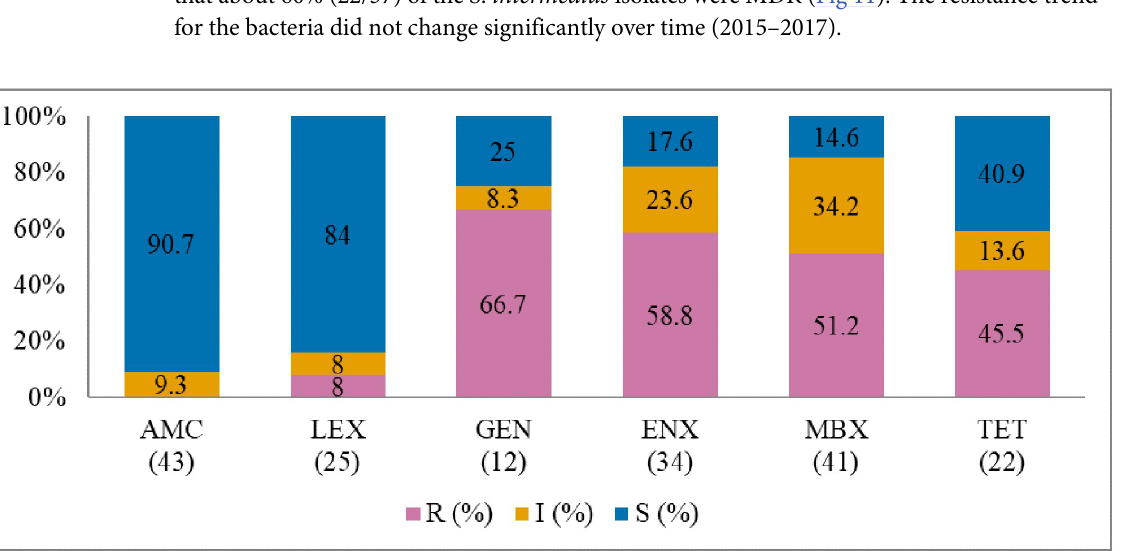
Antibiogram based on the species of bacteria isolated from dogs Antibiogram of the bacteria isolated from dogs is presented in Figs 7–10. The MDR levels for the selected bacterial species (2015–2017) are shown in Fig 11. Staphylococcus intermedius. The AST results for S . intermedius are presented in Fig 7. The highest resistance level was against neomycin (90.9%; 95% CI = 57.1–99.5), gentamicin (84.6%; 95% CI = 53.6–97.3), and tetracycline (75%; 95% CI = 47.4–91.7). It was also noted that about 60% (22/37) of the S . intermedius isolates were MDR (Fig 11). The resistance trend for the bacteria did not change significantly over time (2015–2017).